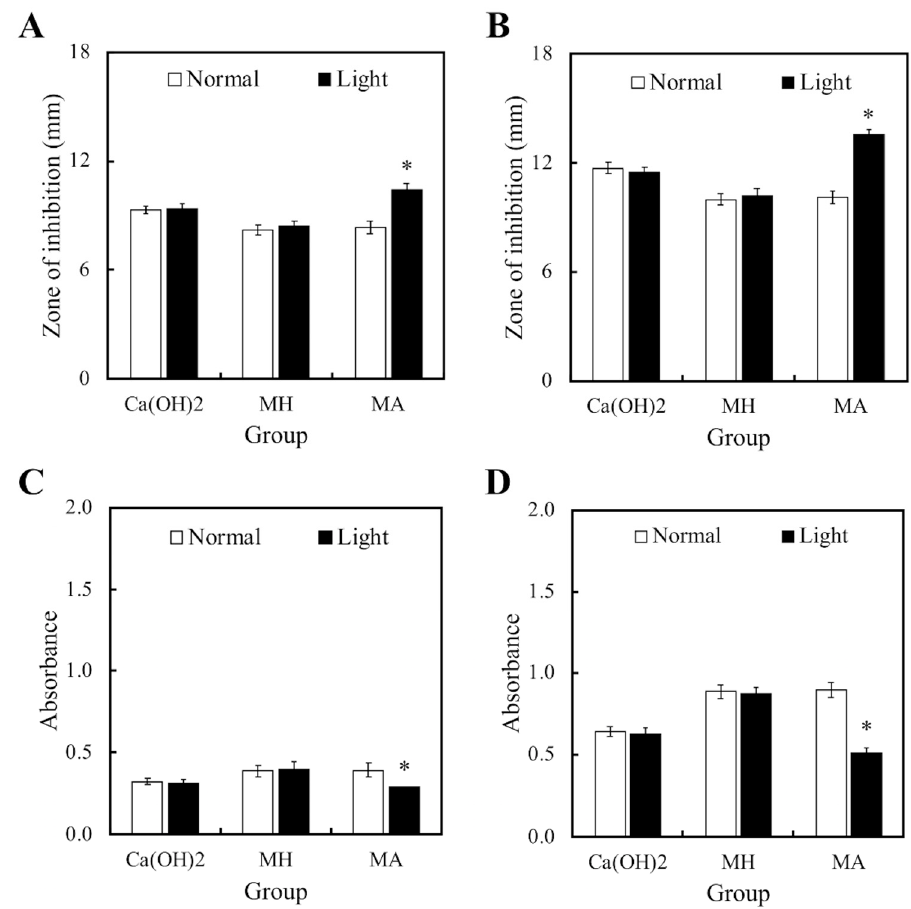
Figure 2. ( A , B ) Zones of inhibition and ( C , D ) the anti-bacterial effects of light- and non-light treated MTA-ALA on ( A , C ) S. aureus and ( B , D ) P. aeruginosa . Data are displayed as means ± SD ( n = 6). “*”, with statistically significant difference ( p < 0.05), compared to the substrate without red light irradiation.